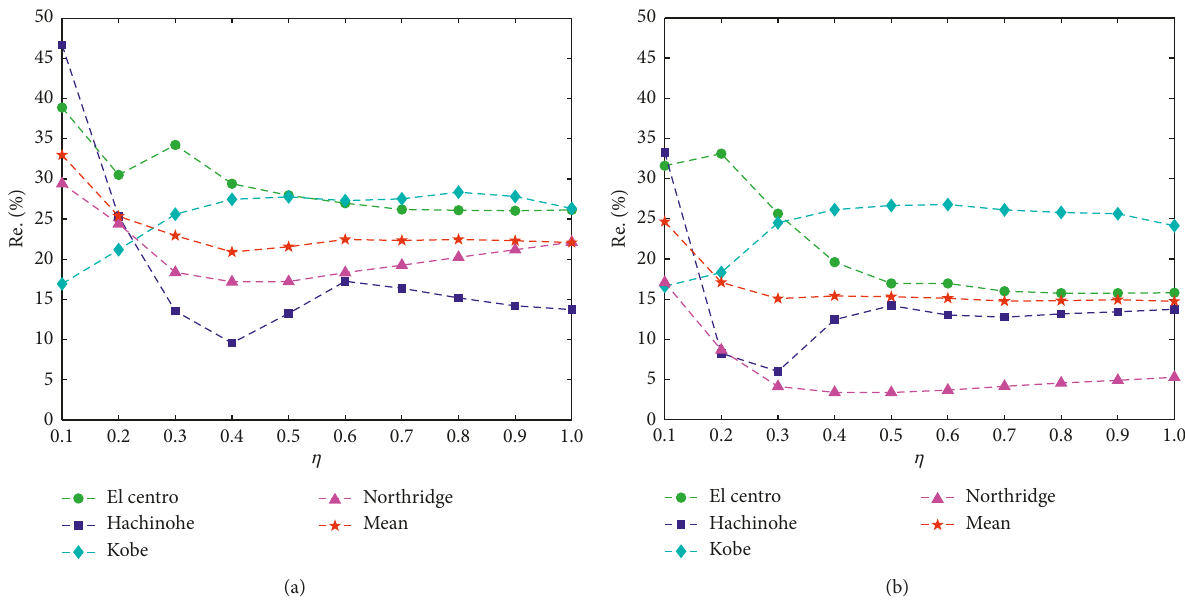
Figure 15: Reduction rates of the structural interstory drift ratios for each scheme ( η respectively): (a) 0.3g conditions; (b) 0.51g